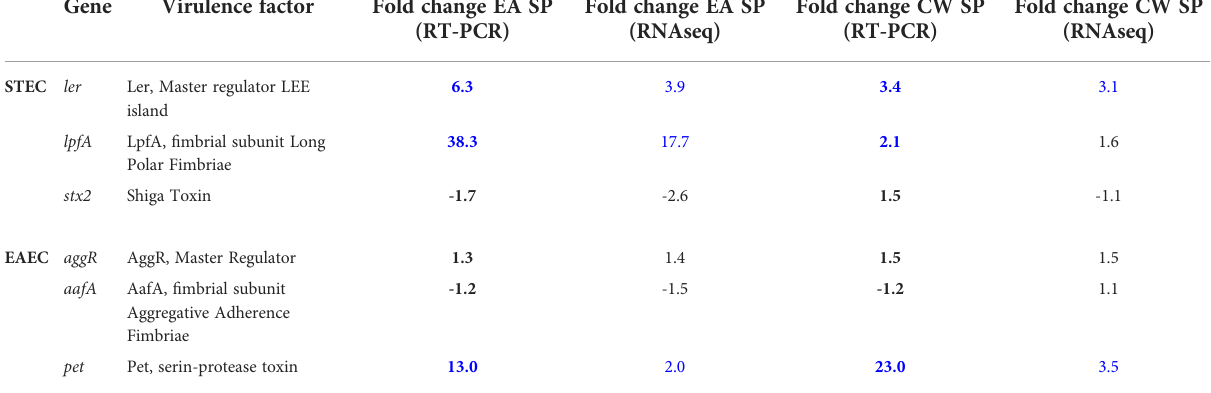
TABLE 3 Con fi rmation RNA-seq results by